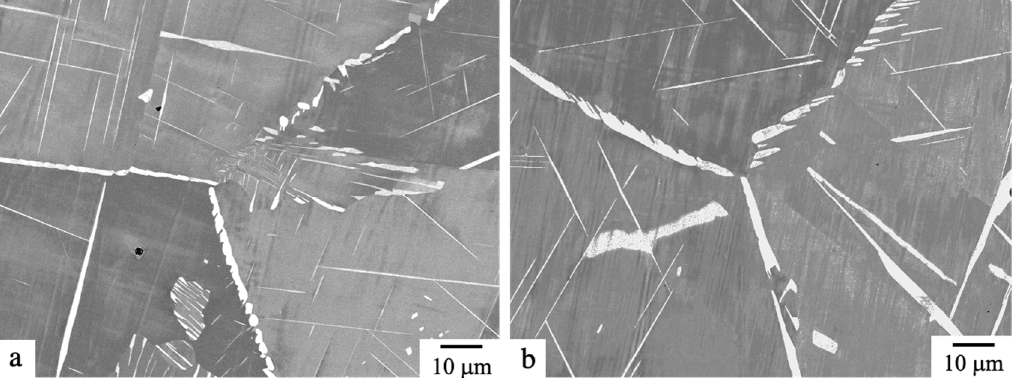
Figure 4. Backscattered electron images of Ni-6Nb-57Co after solution treatment followed by aging at 1273 K for ( a ) 12 h and ( b ) 500 h.